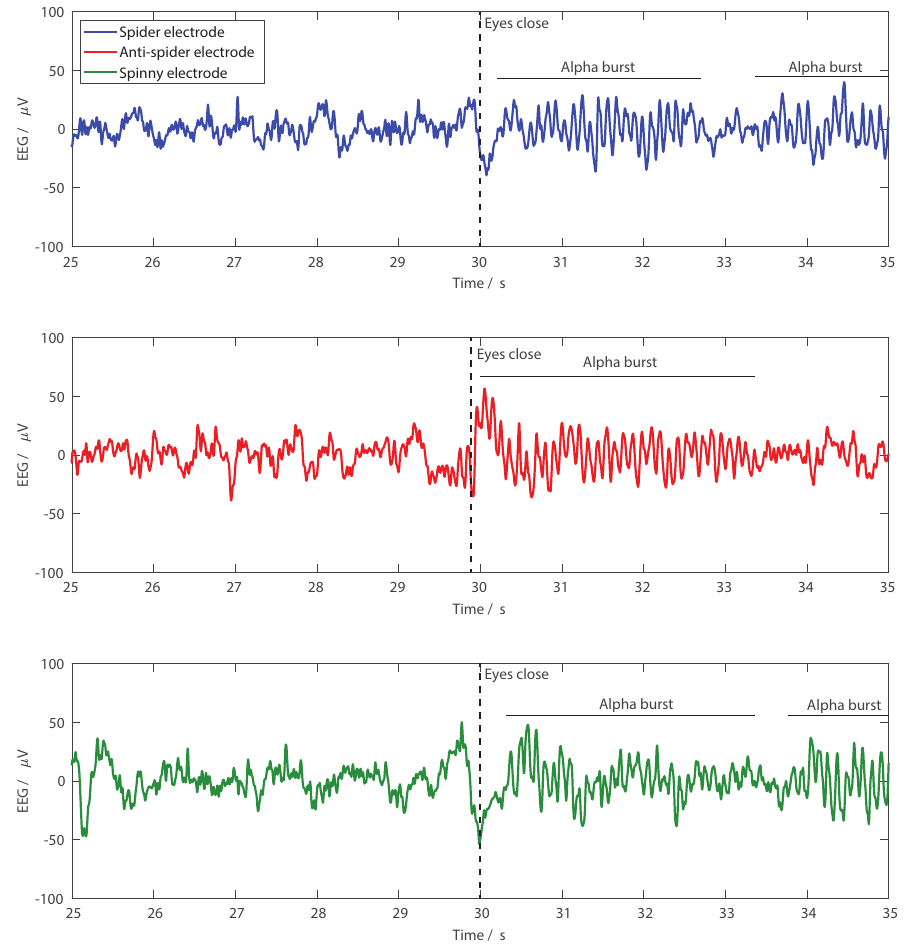
Figure 11. Example EEG recordings from Oz with the three different electrode types. Participants were asked to close their eyes at the 30-s mark, and clear bursts of alpha activity are seen following the eyes closing with all of the electrode